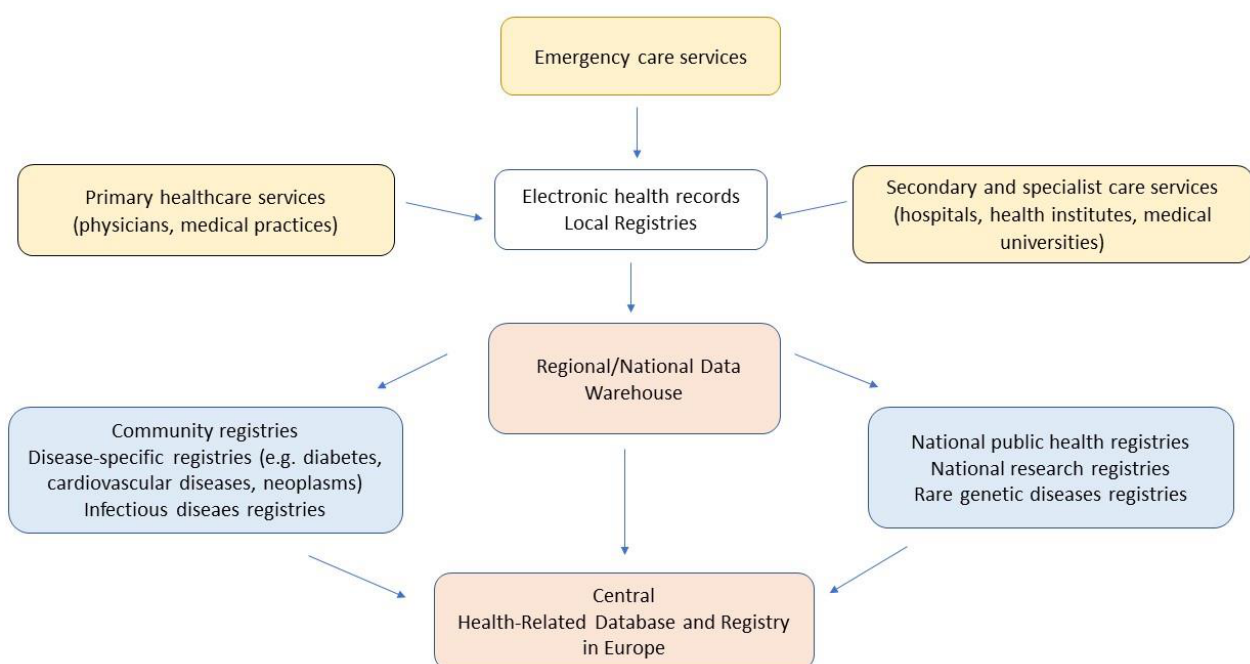
Figure 2. The proposed multilevel structure of the conceptual integrated network of registries containing health-related data (own interpretation, based on [19]).